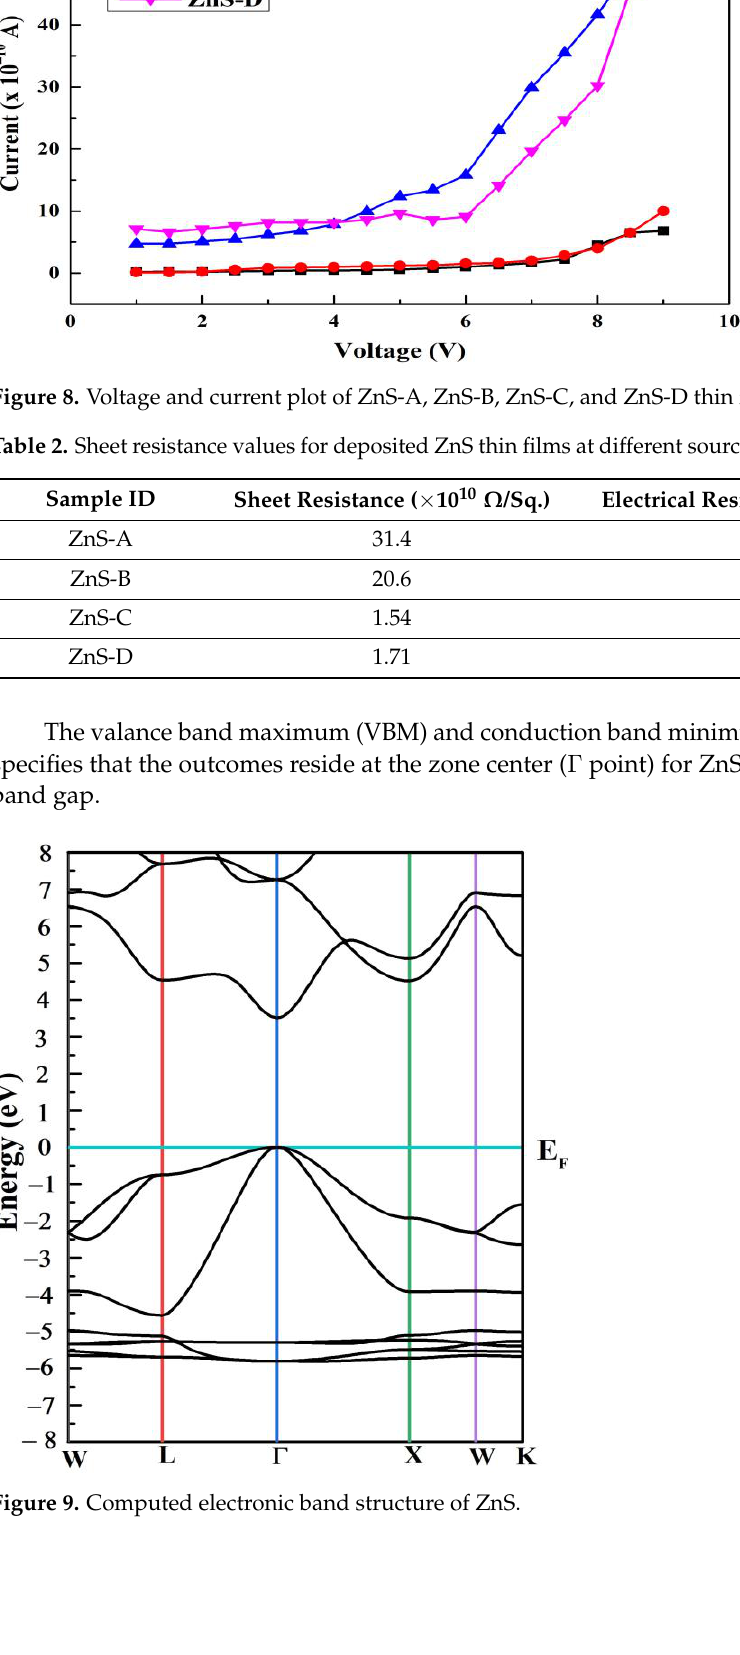
Figure 9. Computed electronic band structure of ZnS.